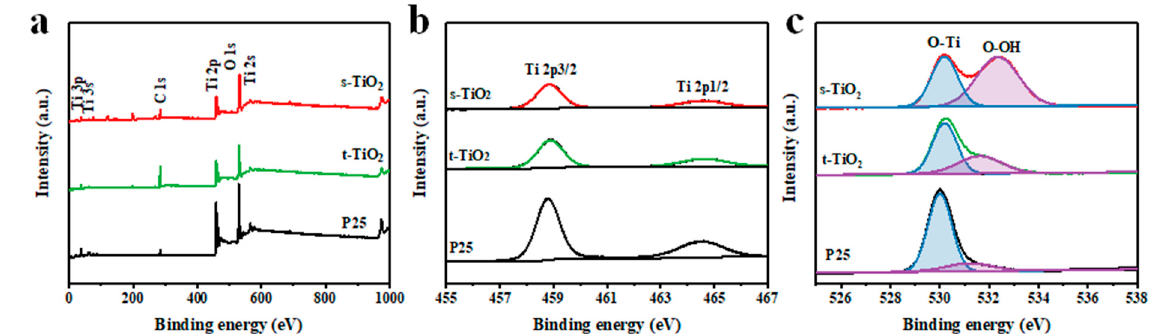
Figure 3. ( a ) XPS overall, ( b ) Ti 2p, and ( c ) O 1s spectrum of s-TiO 2 , t-TiO 2 , and P25.